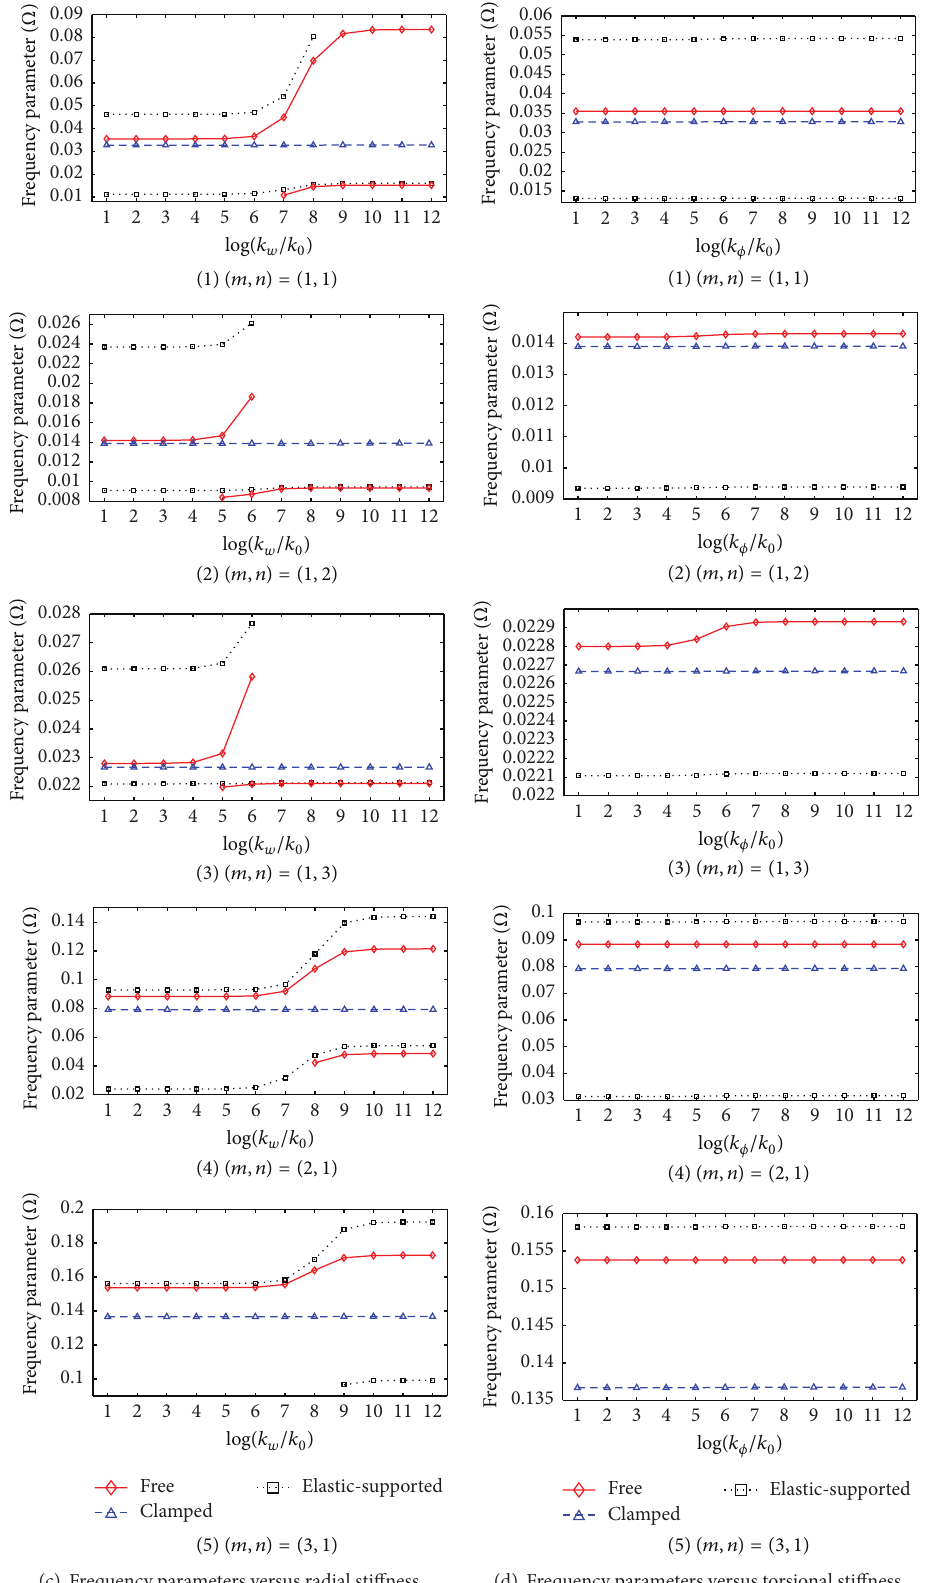
Figure7:Effectofelastic-supportstiffnessonthefrequencyparametersforthefree,theclamped,andtheelastic-supportboundaryconditions (elastic-support stiffness 𝑘 = 1 × 10 7 N/m or